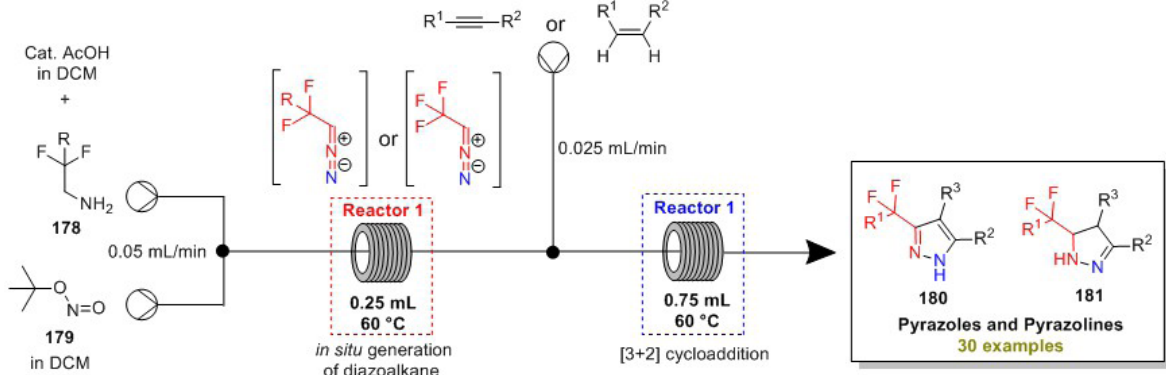
Scheme 41 - Continuous flow synthesis of highly substituted pyrazoles and pyrazolines.